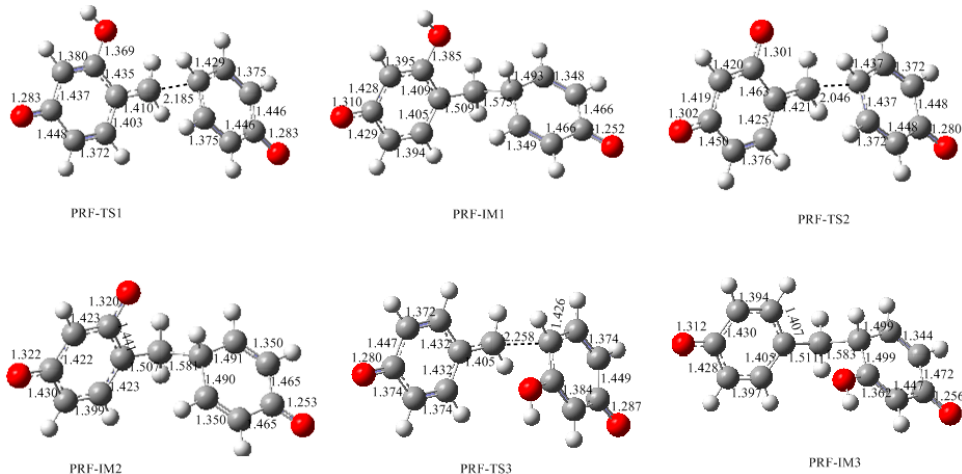
Figure 14. The calculated structures of the transition states and product-like intermediates for the Michael addition reactions in Figure 13.